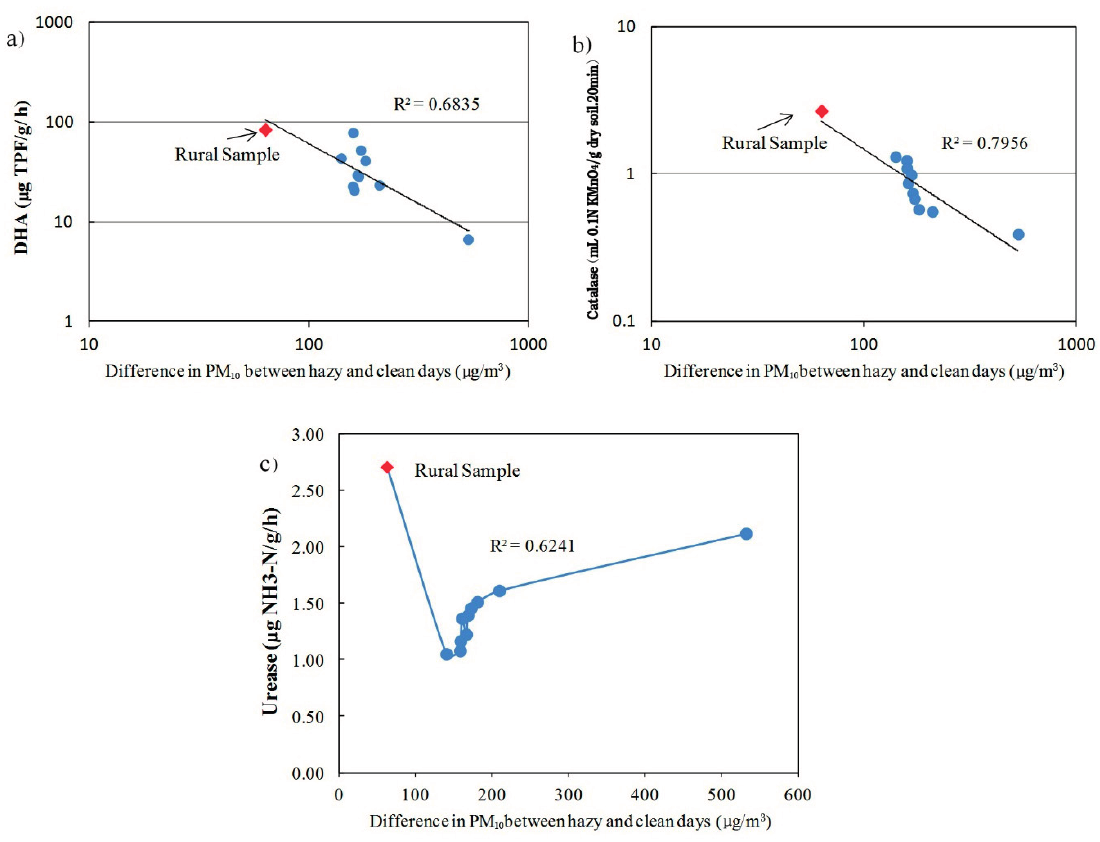
Figure 4. The impacts of exposure to PM 10 on soil enzyme activities: ( a ) DHA; ( b ) catalase and ( c )